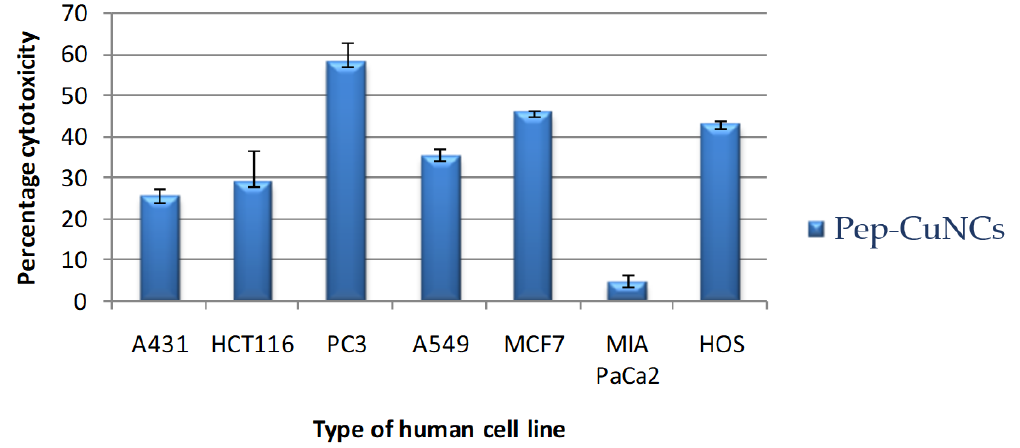
Table 2 as the cytotoxic effect of the samples at values of 100 µ M and IC 50 which reflect the effect of the synthesized particle on the cancer cells in the current investigation.